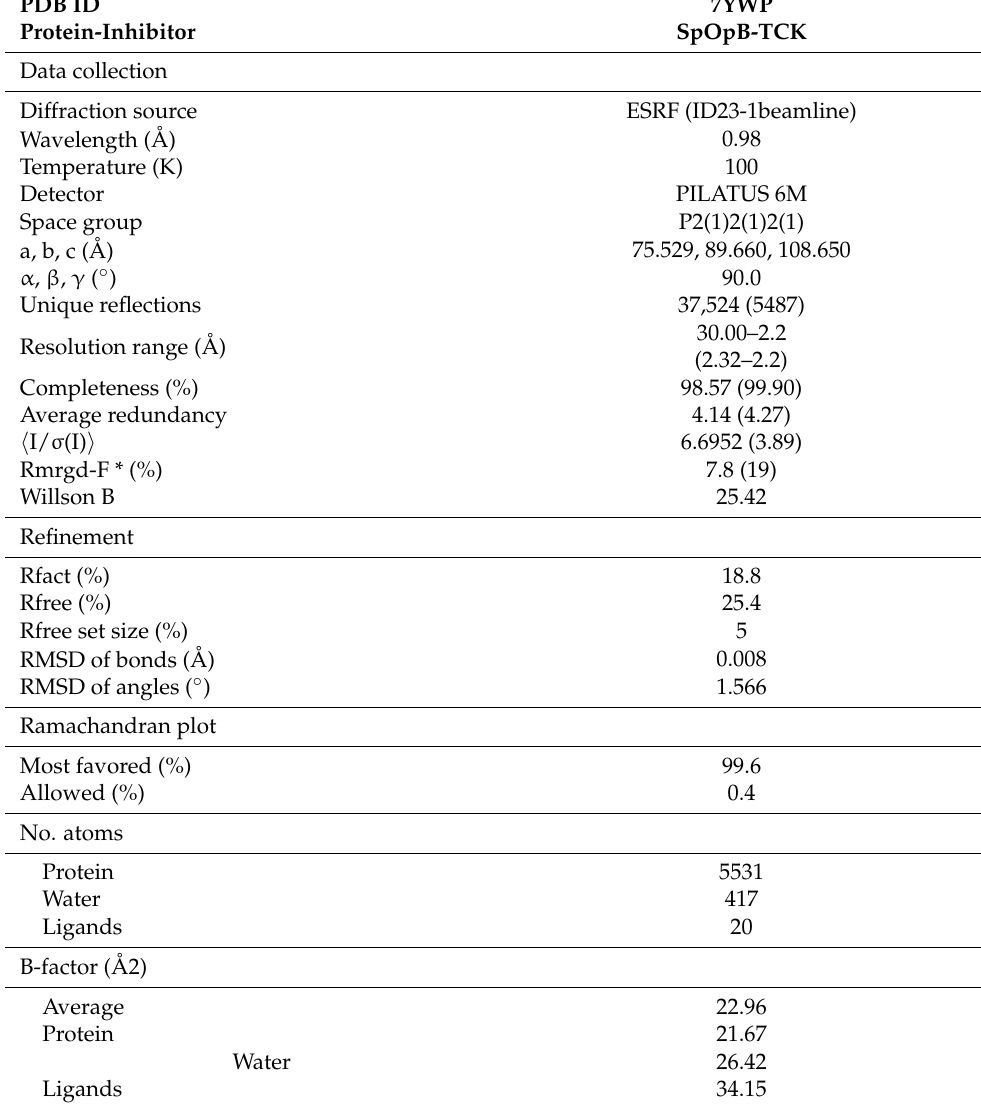
Table 5. Data collection, processing, and